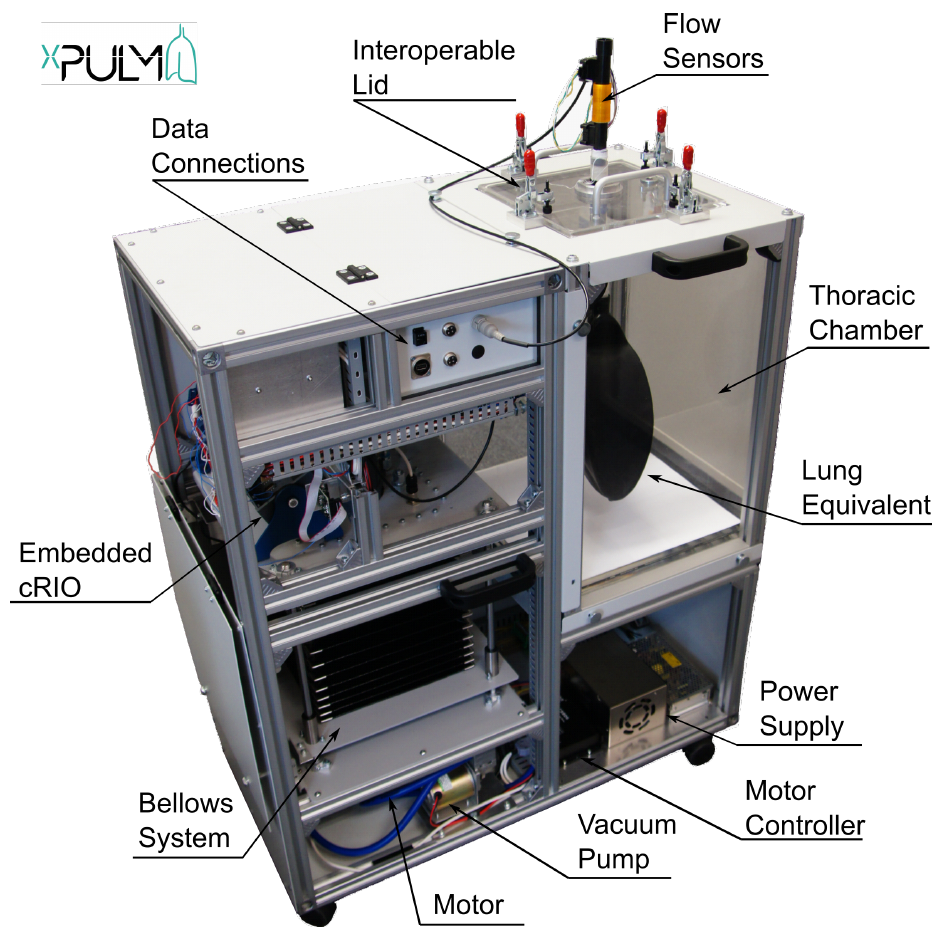
Figure 2. Key functional elements of the xPULM™ electromechanical lung simulator